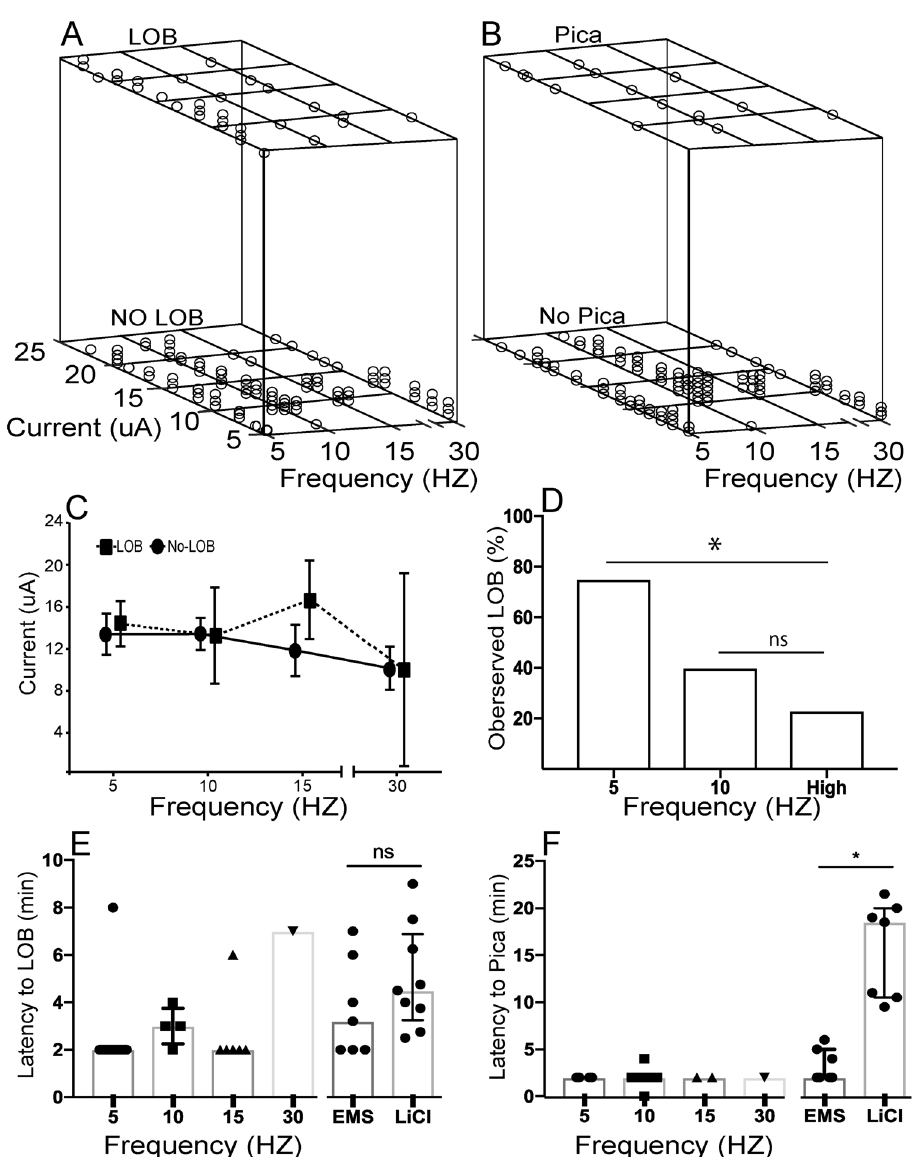
Figure 6. Electrical stimulation of the pIC at low frequencies triggered LOB and Pica. ( A – B ) Scatter-plots of behavioral outcome considering the whole set of trials in relation to frequency and current levels of EMS. In both plots, the value 1 in the Z-axis represents that LOB or Pica was triggered by stimulation of the pIC. ( C ) Magnitude of current necessary to trigger LOB at different frequencies of EMS. Vertical bars denote 0.95 confidence intervals ( D ) Summary of behavioral outcome for the total number of sessions at different frequency of EMS. ( E – F ) Latency to LOB and Pica onset at different frequencies per each experiment. Then a latency to LOB and Pica comparison between EMS (all frequencies per animal) and IP LiCl injection. Bars represent median and whiskers the interquartile